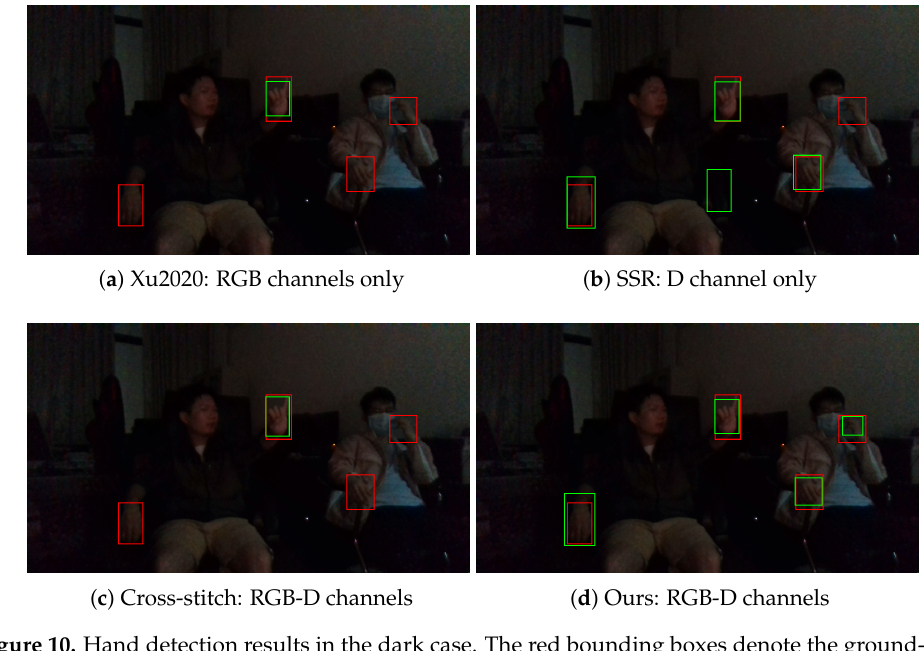
Figure 10. Hand detection results in the dark case. The red bounding boxes denote the ground-truth labels, and the green bounding boxes denote the detection results.